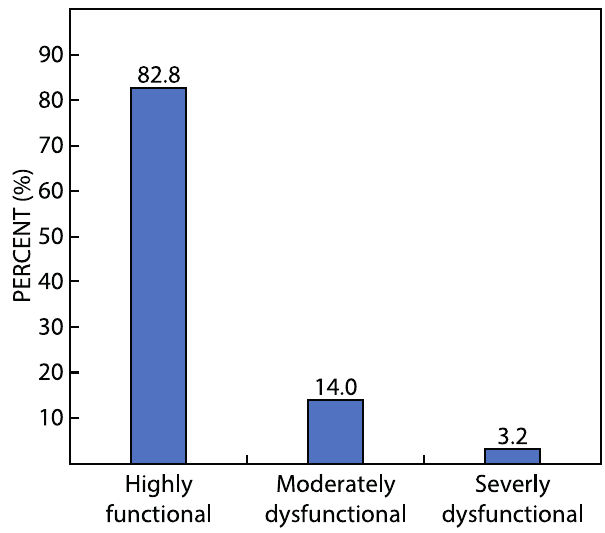
Figure 1: Perceived family function of